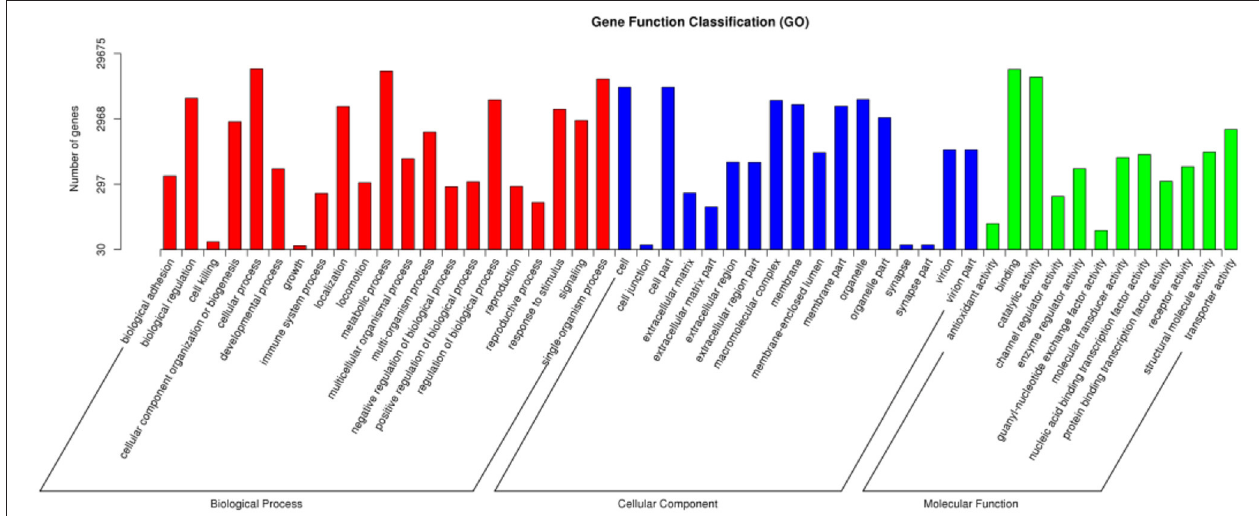
FIGURE 2 | Gene function classification via GO annotation. The differentially expressed genes are grouped into three hierarchically structured GO terms: biological process, cellular component, and molecular function. The y-axis indicates the number of genes in each GO term.